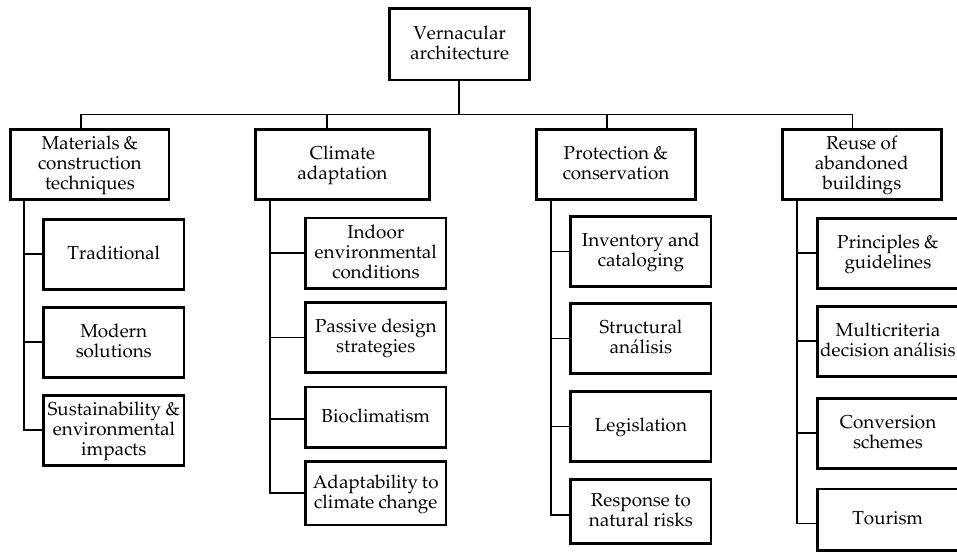
Figure 2. Research topics in vernacular architecture identified in the literature review.